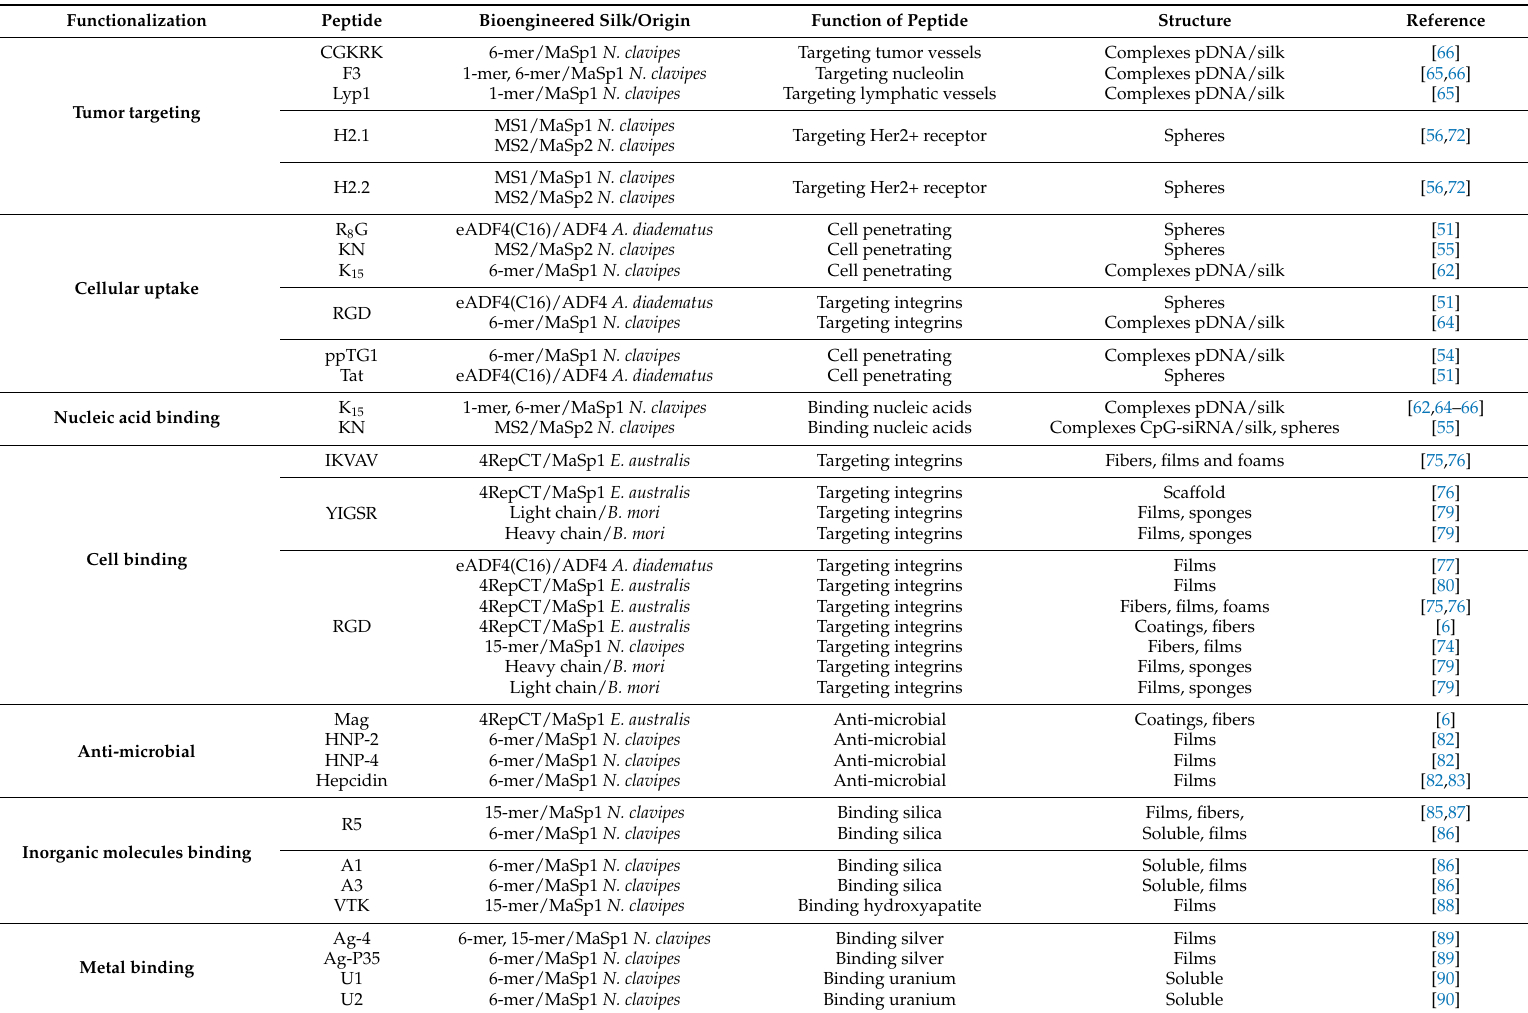
Table 1. Functionalization of bioengineered silks with